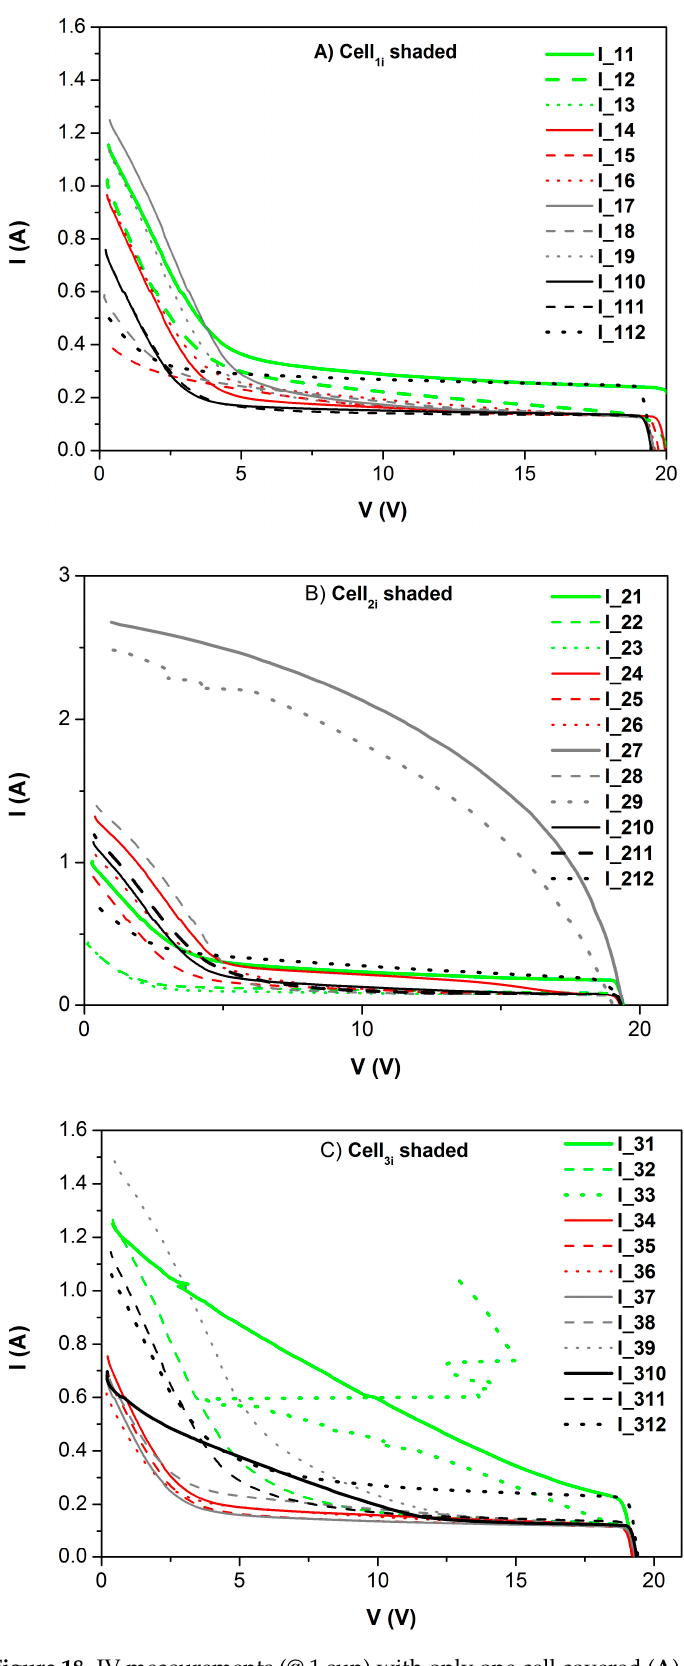
Figure 18. IV measurements (@ 1 sun) with only one cell covered ( A ) first string, ( B ) second string and ( C ) third string (remember the 36 cells, the 3 strings, are connected in series).